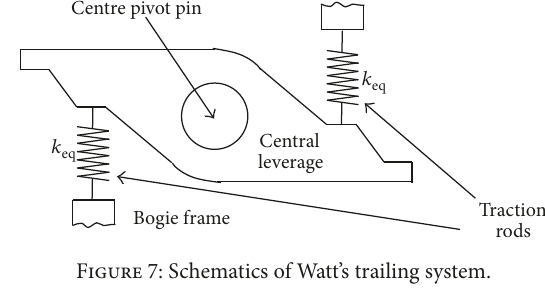
Figure 7: Schematics of Watt’s trailing system.